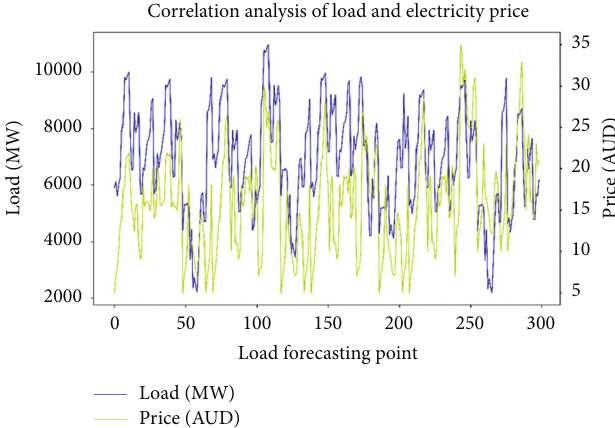
Figure 2: Curve of electricity price and load.